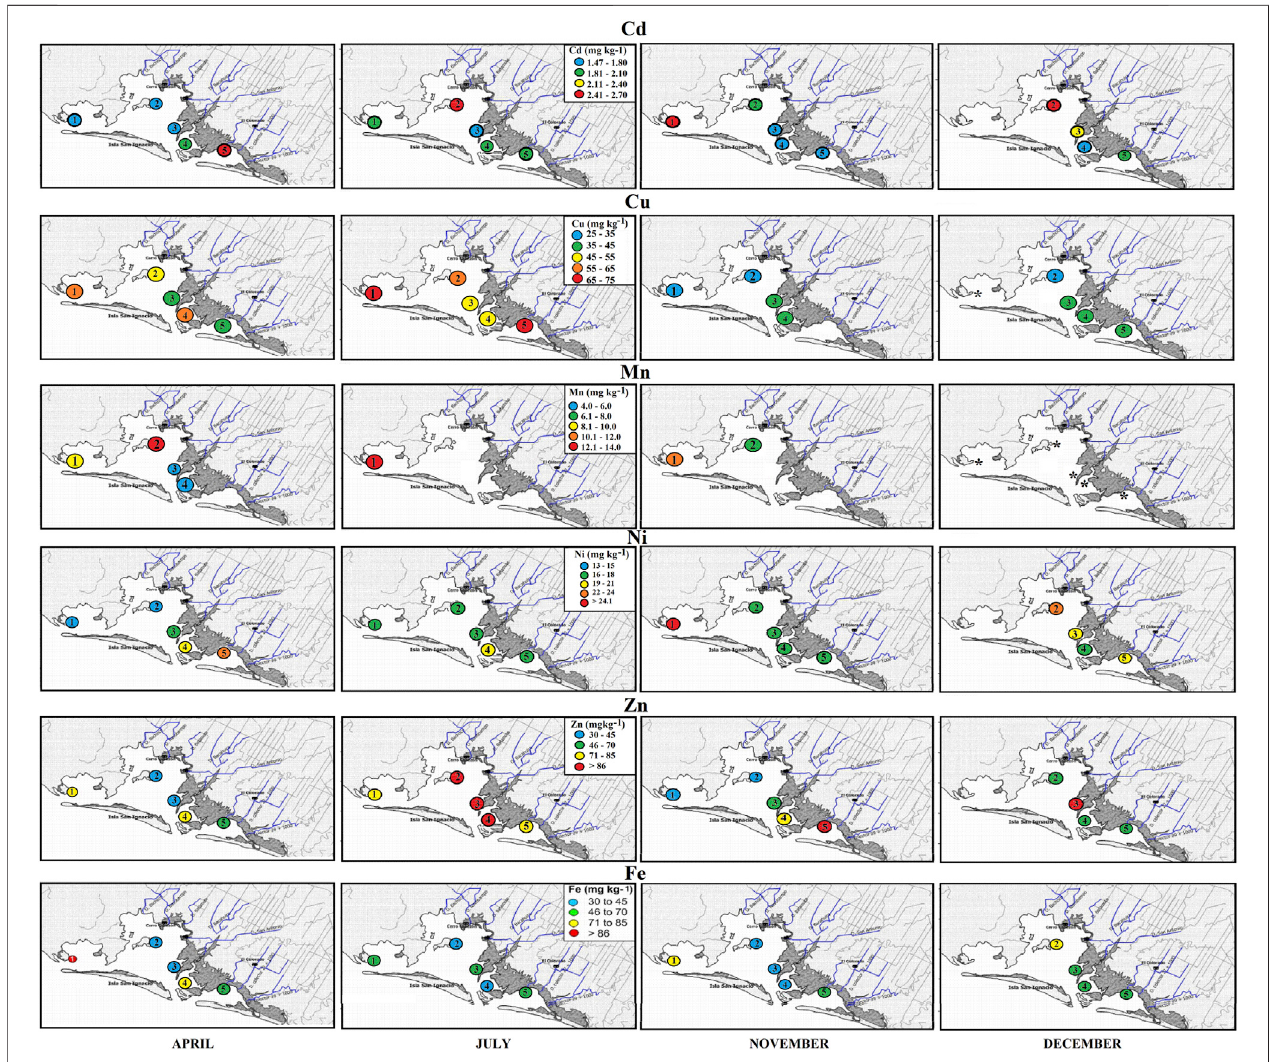
FIGURE 2 | Average trace metal concentration in the edible tissue of C. bellicosus from the collecting sites in the NAV complex, Mexico.